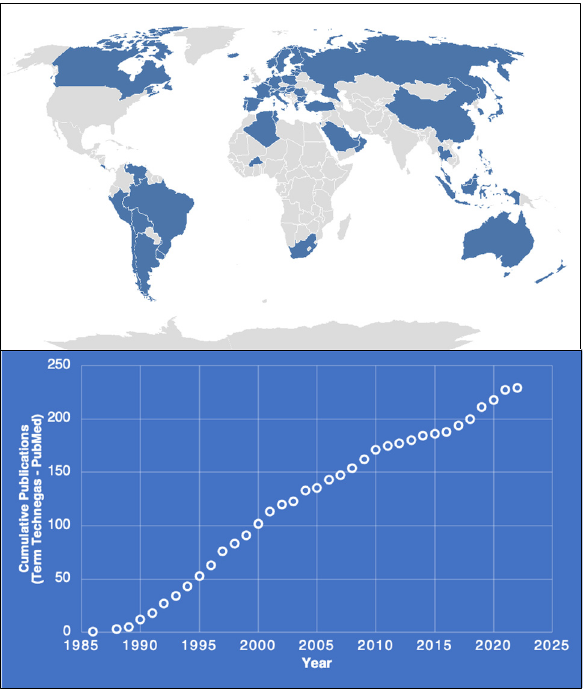
Figure 2. Global registration of Technegas as of August 2022 (blue areas on the map) and cumulative publication record as a function of year (PubMed Technegas).